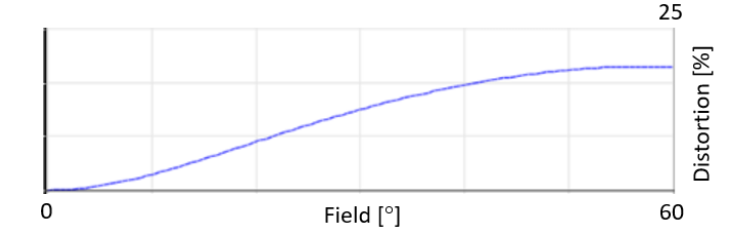
Figure 6. A close look at the (barrel) distortion. This aberration increases with the FOV to reach a maximum of 23% at ±